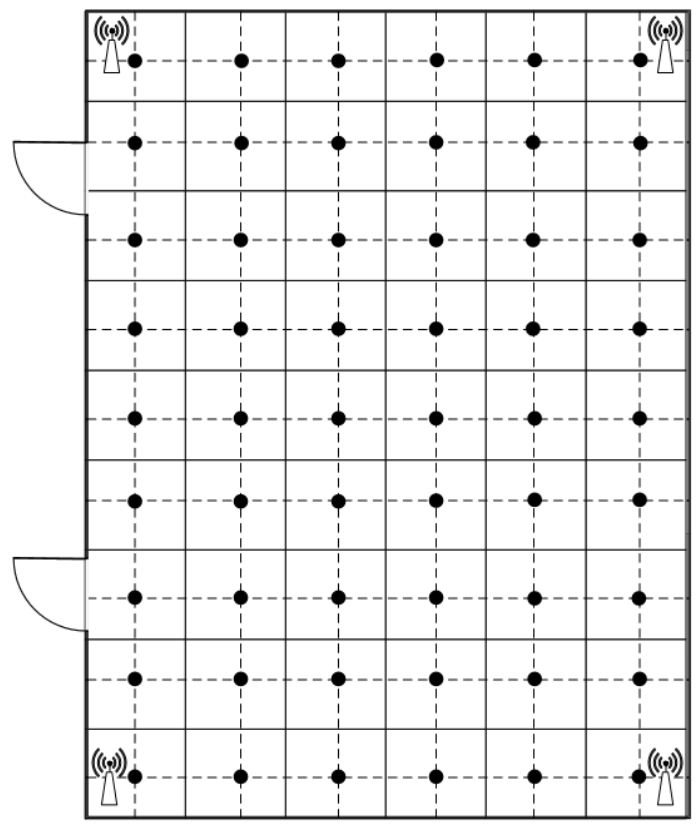
Figure 5. Physical testing area.